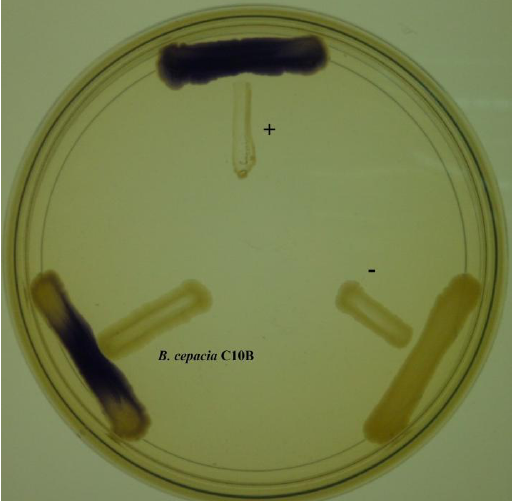
Figure 1. AHL screening of strain C10B with CV026. E. carotovora PNP22 (negative control ―−‖) devoid of QS activity was included and E. carotovora GS101 (positive control ―+‖) that can activate CV026 was included for